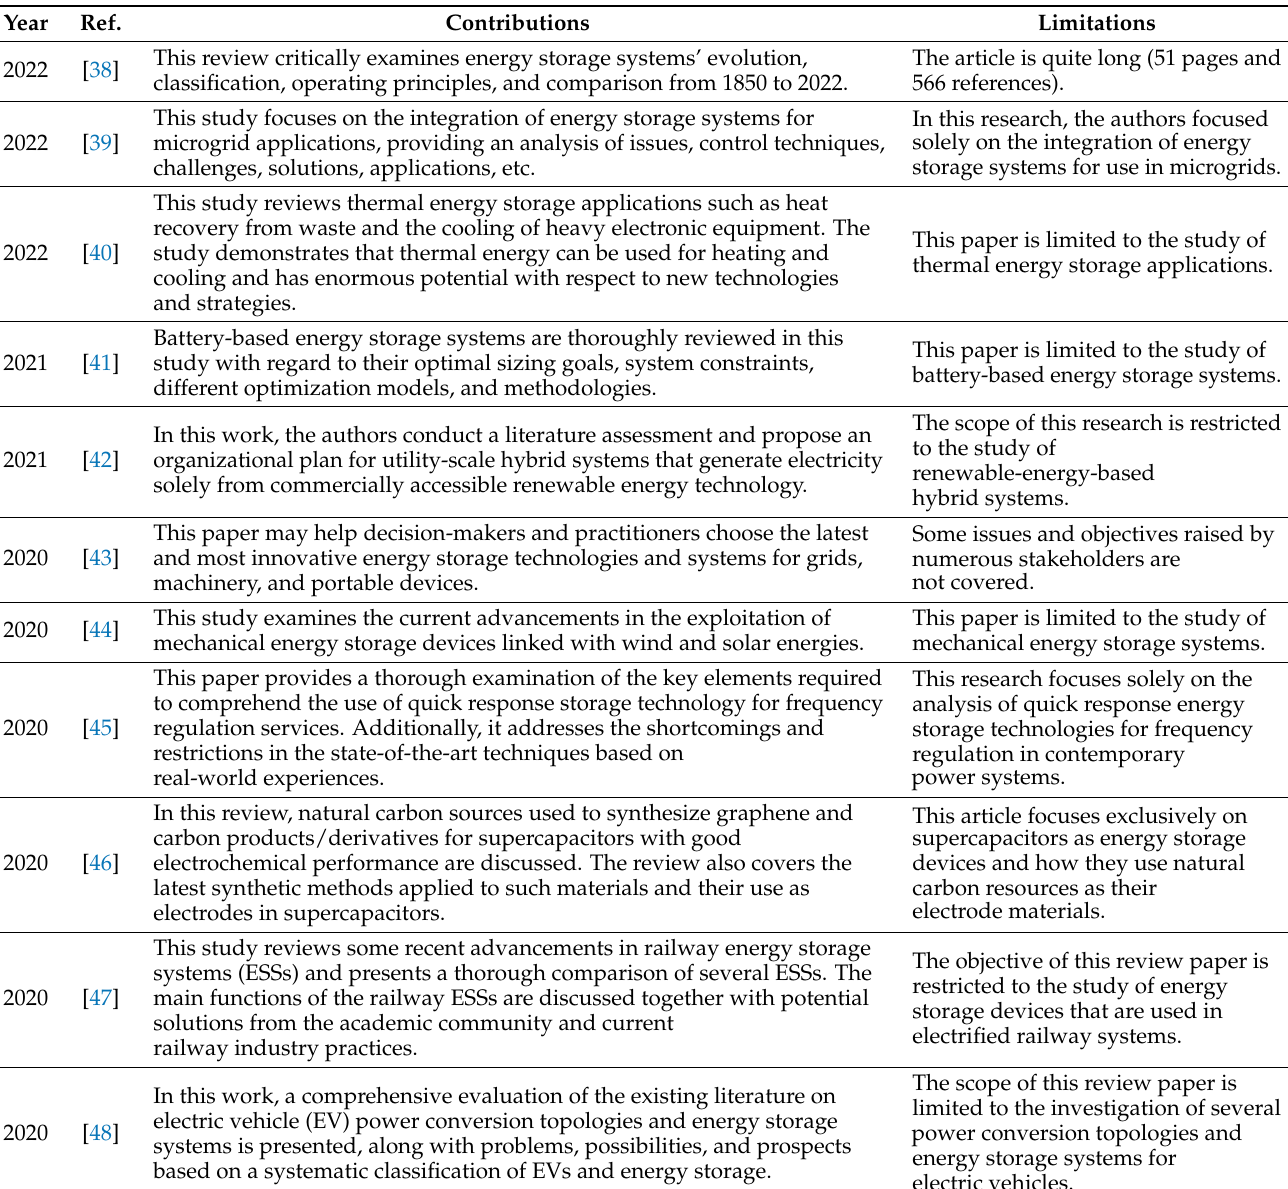
Table 1. Summary of the main results and limitations of some relevant